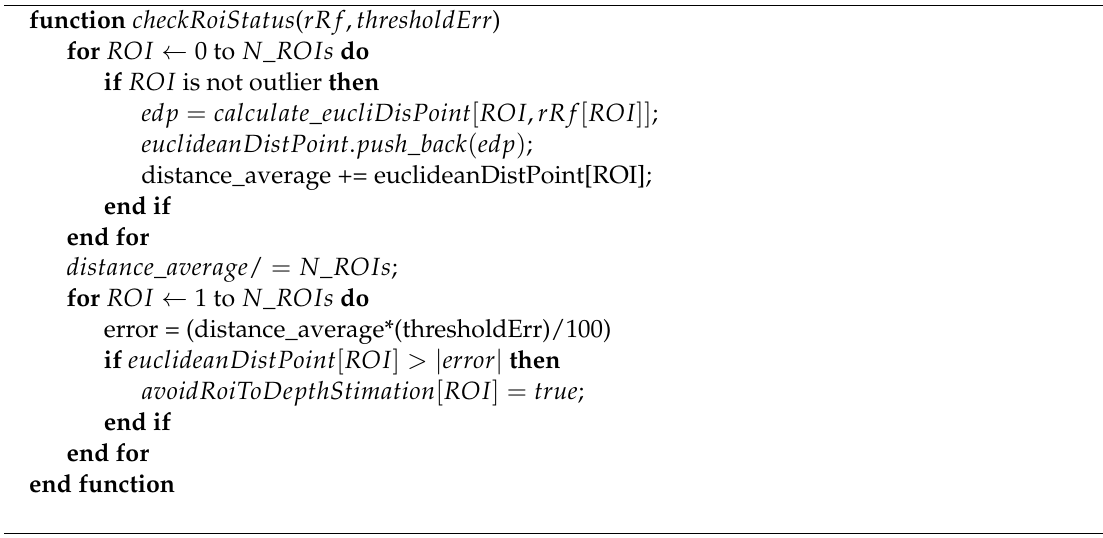
Algorithm 2 Euclidean-based threshold to avoid the wrong behaviour of the squares, where rR f is the initial reference position of each ROI, and thresholdErr the threshold set by the user. function checkRoiStatus ( rR f , thresholdErr )